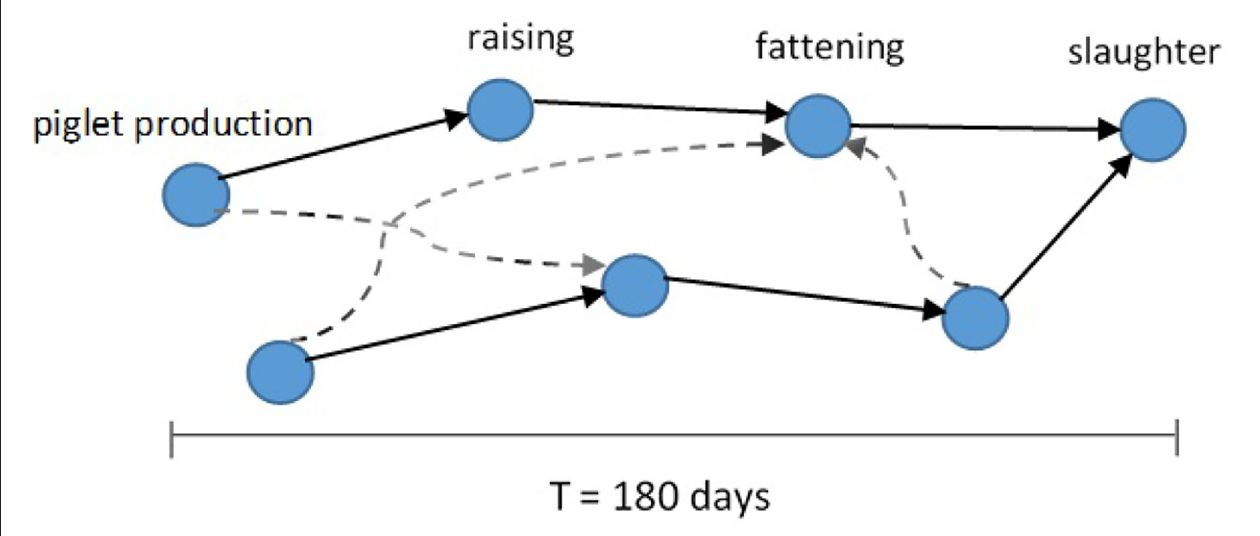
FIGURE 2 | Schematic of pork production chains (solid arrows) forming the pig trade network. Different production chains can be connected by additional cross links (dashed arrows) (